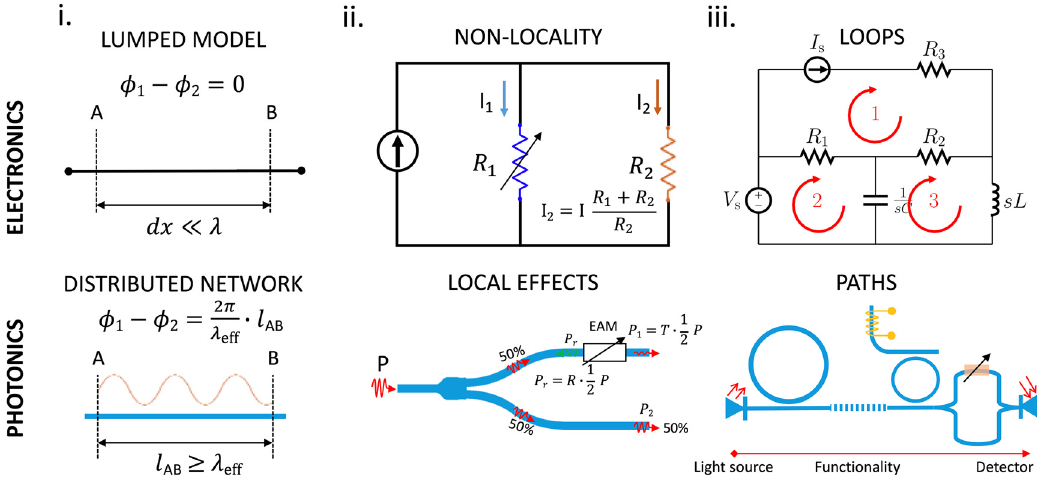
Figure 1: Fundamental differences between electronics and photonics impacting design and functionalities. ( i ) Electric circuits have a footprint signi fi cantly smaller than the operating wavelength, thus can be approximated via a lumped model ( ϕ − ϕ ∼ 0 ) ;whileinphotonicsthewavelengthof theelectric fi eldissigni fi cantlysmallerthanthenetwork. ( ii )Inelectriccircuitsnonlocality 1 2 holdstrue,wherelocalvariationsdoaffecttheentirenetworkfunctionality,whileinphotonicslightintensityisonlyaffectedlocally(e.g.,after beingmodulated). Outputpower P 1 and P 2 of the splitteris giveninterms of T (transmittance), R is there fl ectance.( iii ) Electriccurrent fl owsin loops, while light is generated, then follows set pathways, which provides a certain functionality, and is ultimately